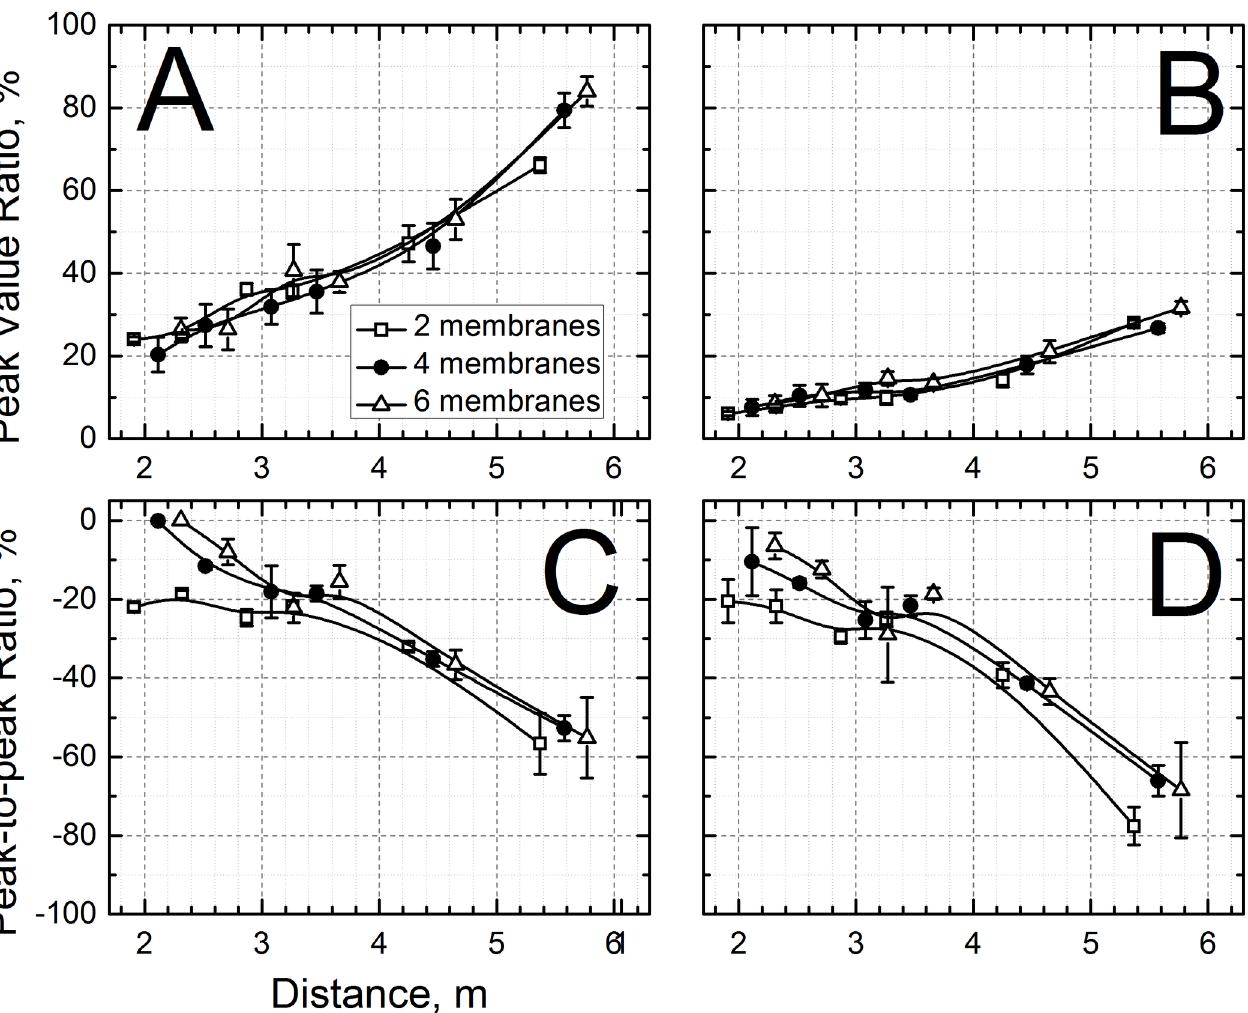
Fig 5. The ratios of peak overpressure between incident and reflected shock wave measured at different locations inside of the shock tube as a function of sensor distance from the breech and blast intensity: A) 0.625 ” gap, B) 2 ” gap between end of the shock tube and reflector plate. The ratios between incident peak overpressure and the lowest level (through) of measured reflected underpressure for blasts generated when the gap between the end of the shock tube and reflector plate was 4 ” (C) and with open end (D). The data points were horizontally shifted for clarity of